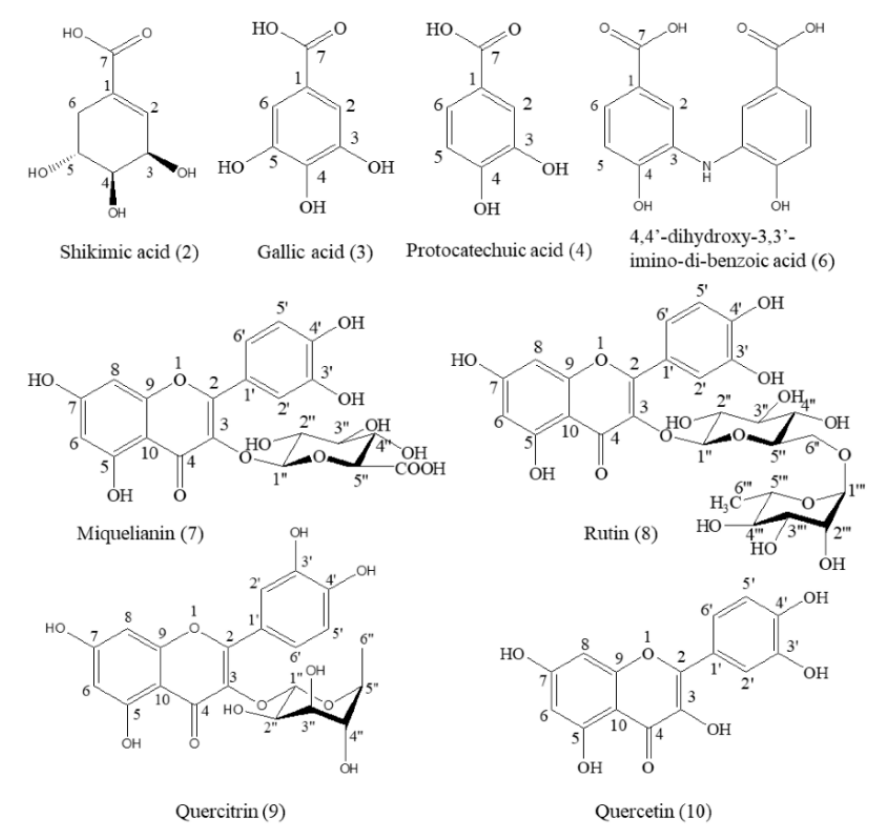
Figure 6. Structures of the compounds separated from the 70% methanol extract of M.